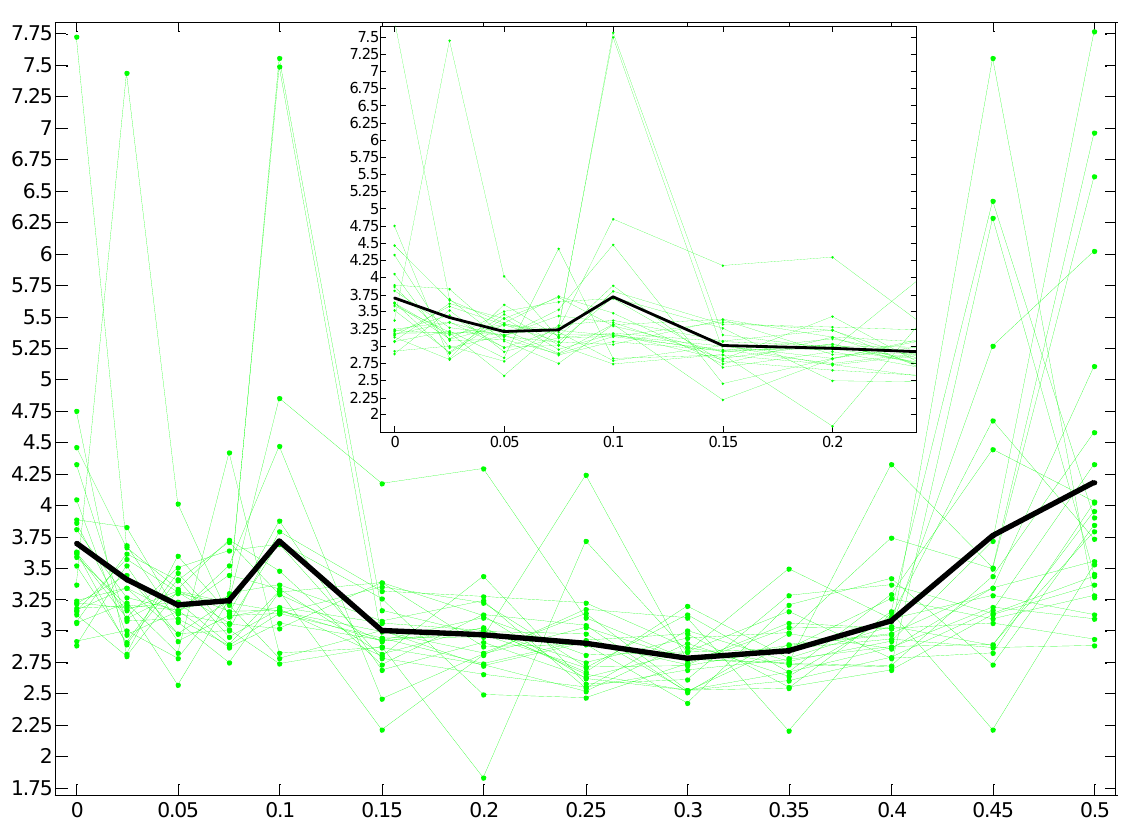
Fig. 6. Relative TPD for those 25 polylines making the evaluation in Fig. 4 (the averaged TPD polyline is